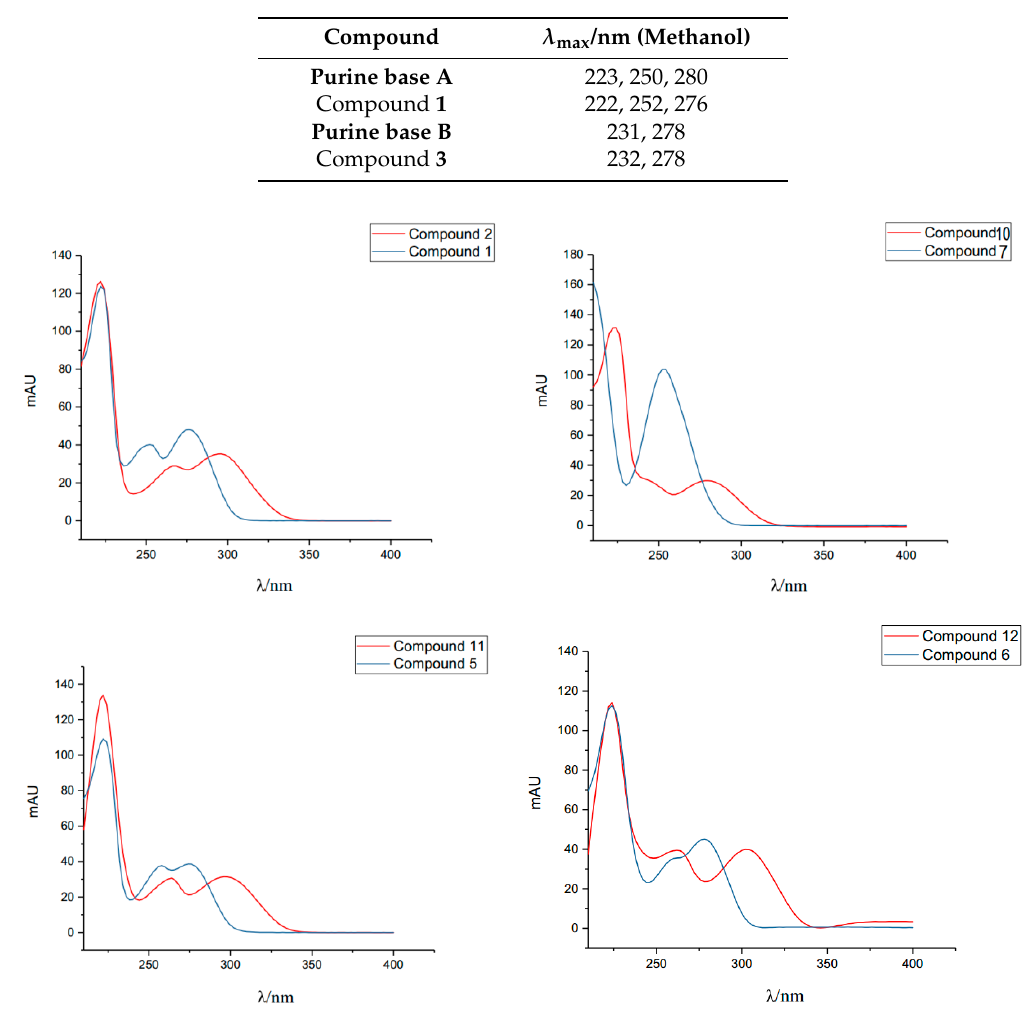
Table 1. UV absorption maxima of bases and corresponding nucleosides in methanol.